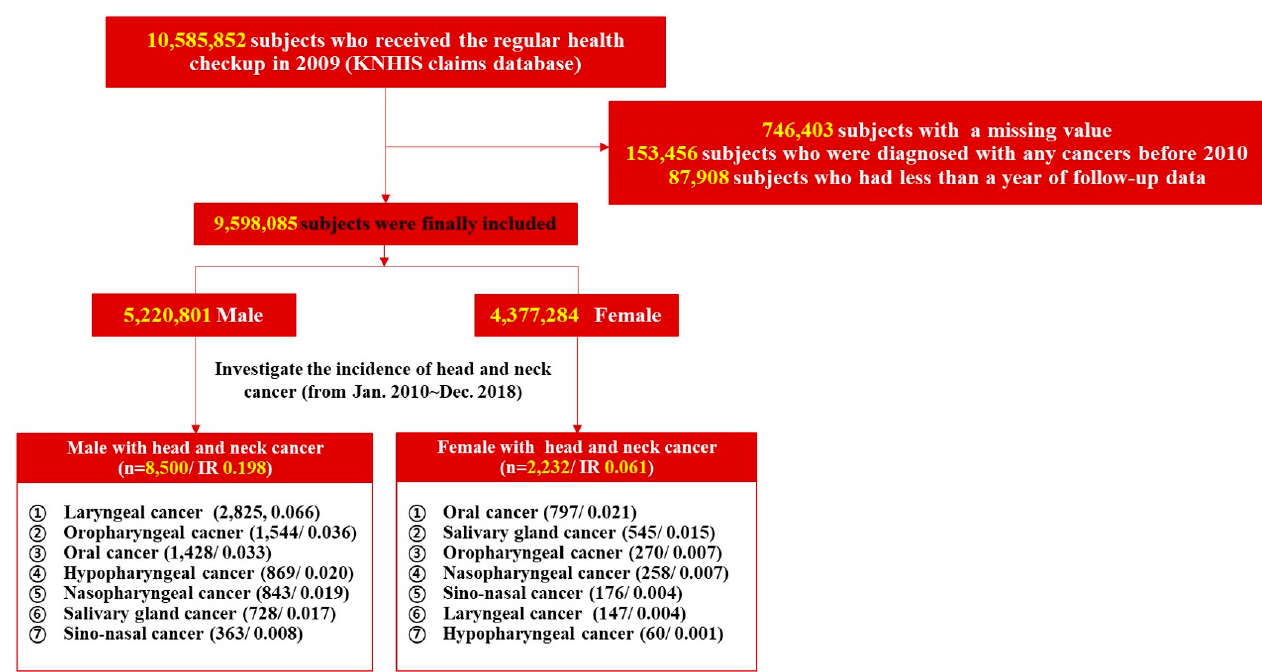
Figure 1. Flow chart of the study. Abbreviations: KNHIS, Korean National Health Insurance Service; IR, incidence rate per 1000 person-years.